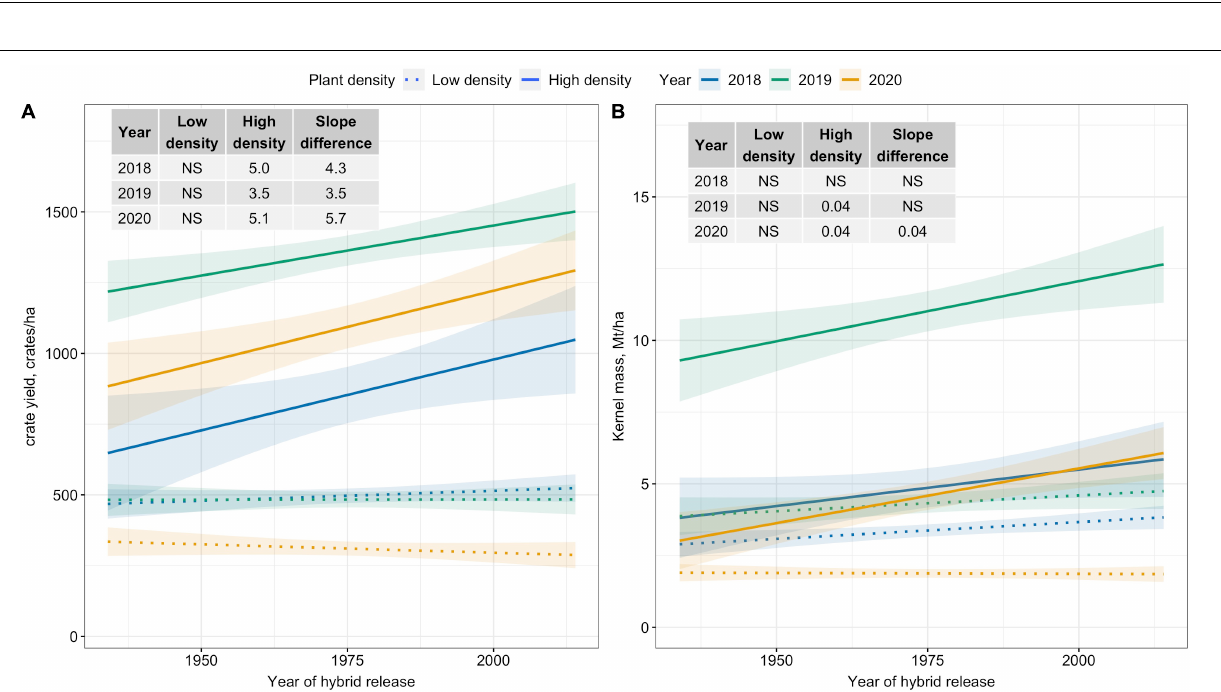
Frontiers in Plant Science |